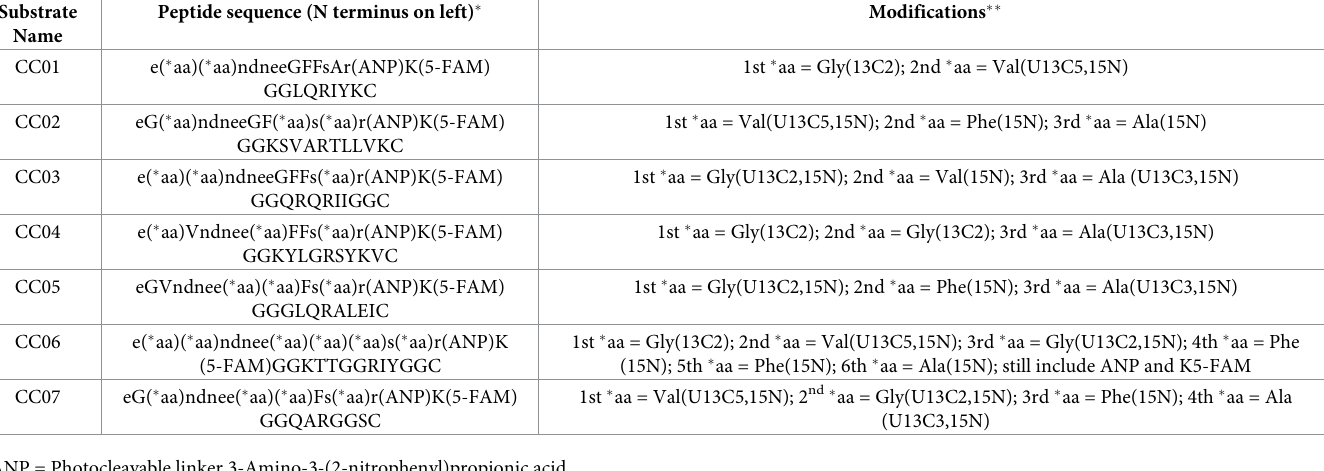
Table 1. Mass-barcoded peptide substrate sequences. Table describing the sequences of the mass-barcoded peptide substrates along with their chemical modifications. ANP was used as a photocleavable linker to enable rapid detachment from the microparticles. 5-FAM was used for rapid quantification via fluorescence. Isotope enrich- ment modifications were used to distinguish mass barcodes for quantification with mass